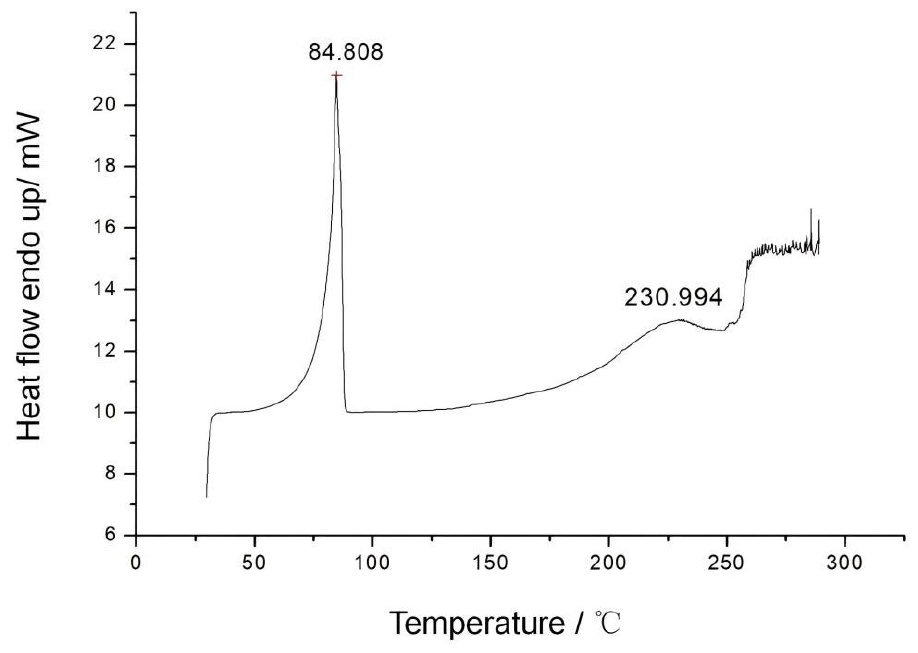
Figure 9. DSC curve of benzoxazine (eugenol) .